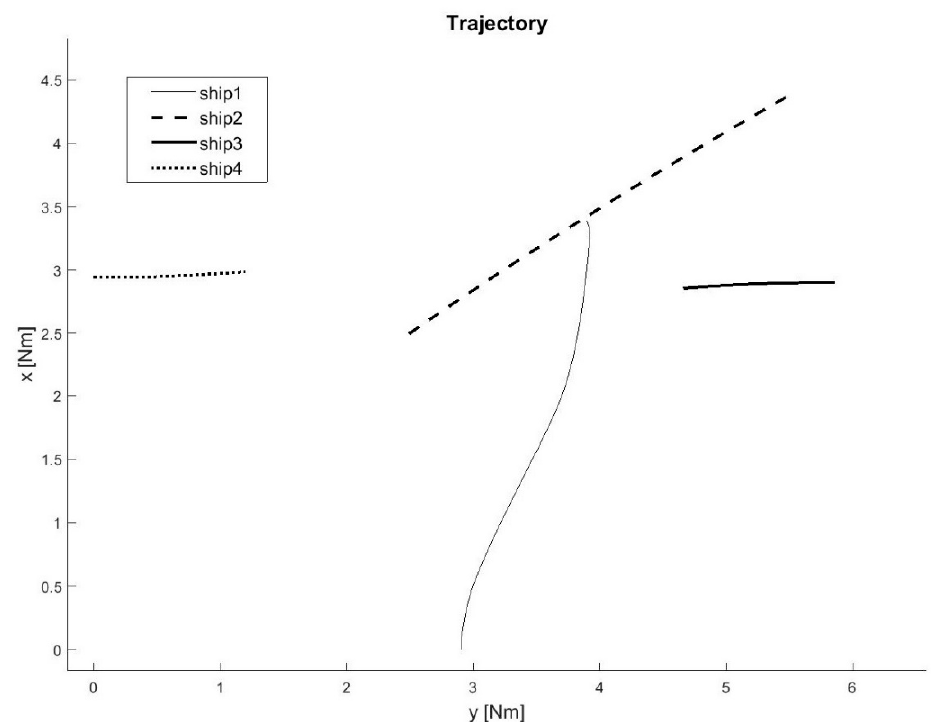
Figure 8. Scenario of a collision situation encountered by four ships — Example 1.